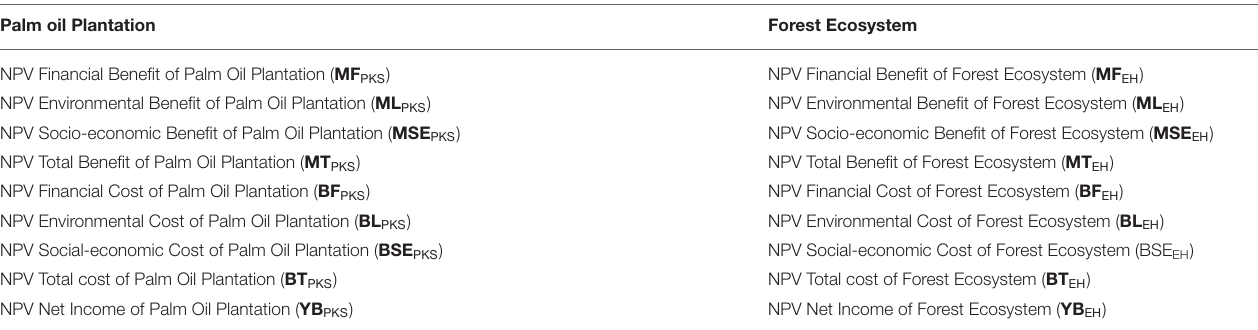
TABLE 4 | Research tools.